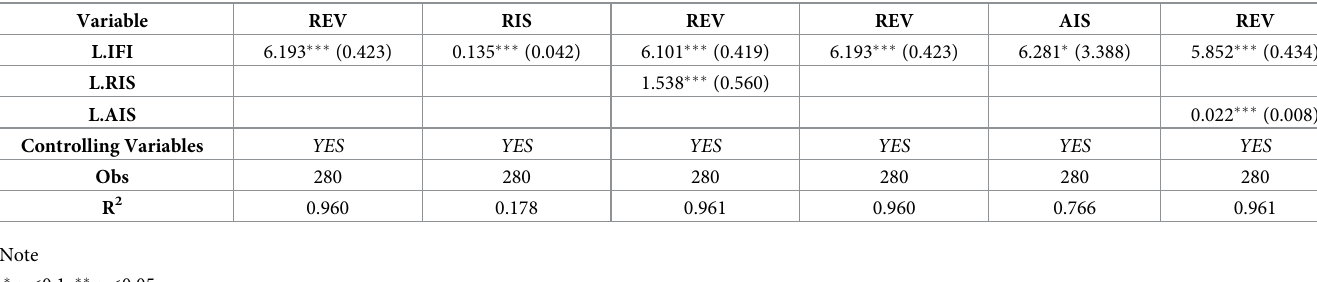
Table 11. Endogenous